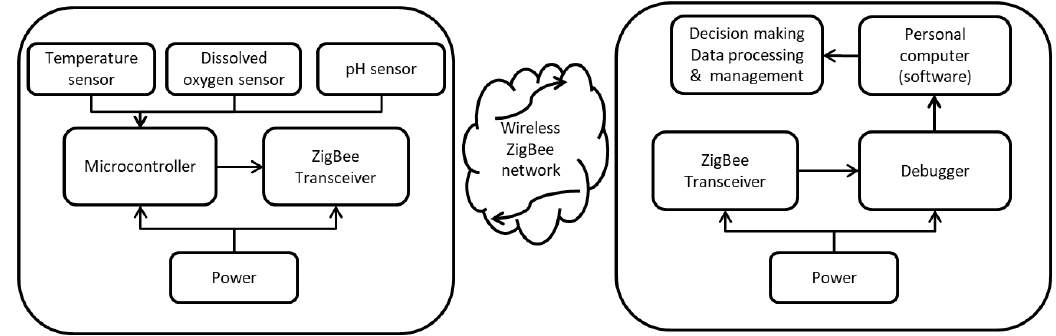
Figure 1. System component structure.